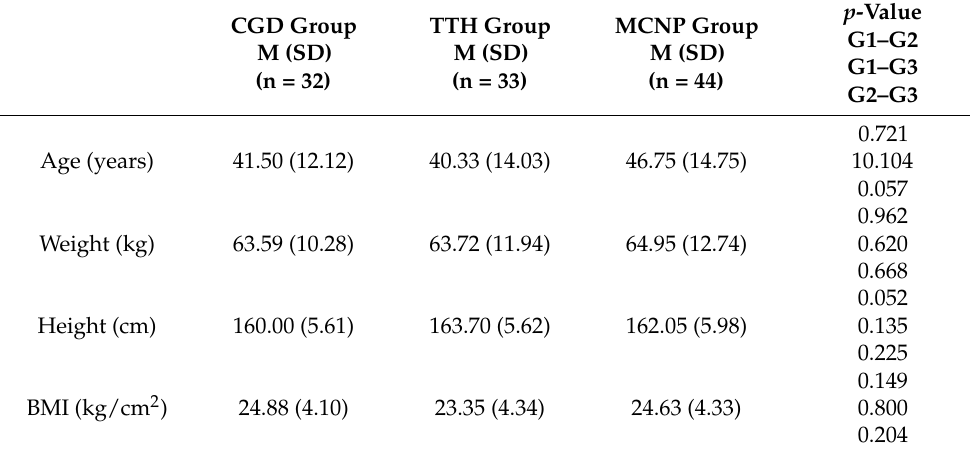
Table 1. Demographic variables of the three